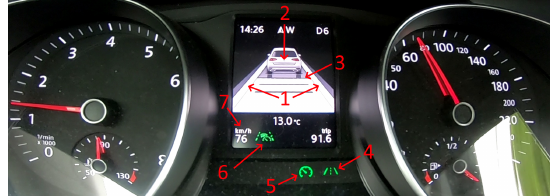
Figure 8. VW HMI design and corresponding icon number.